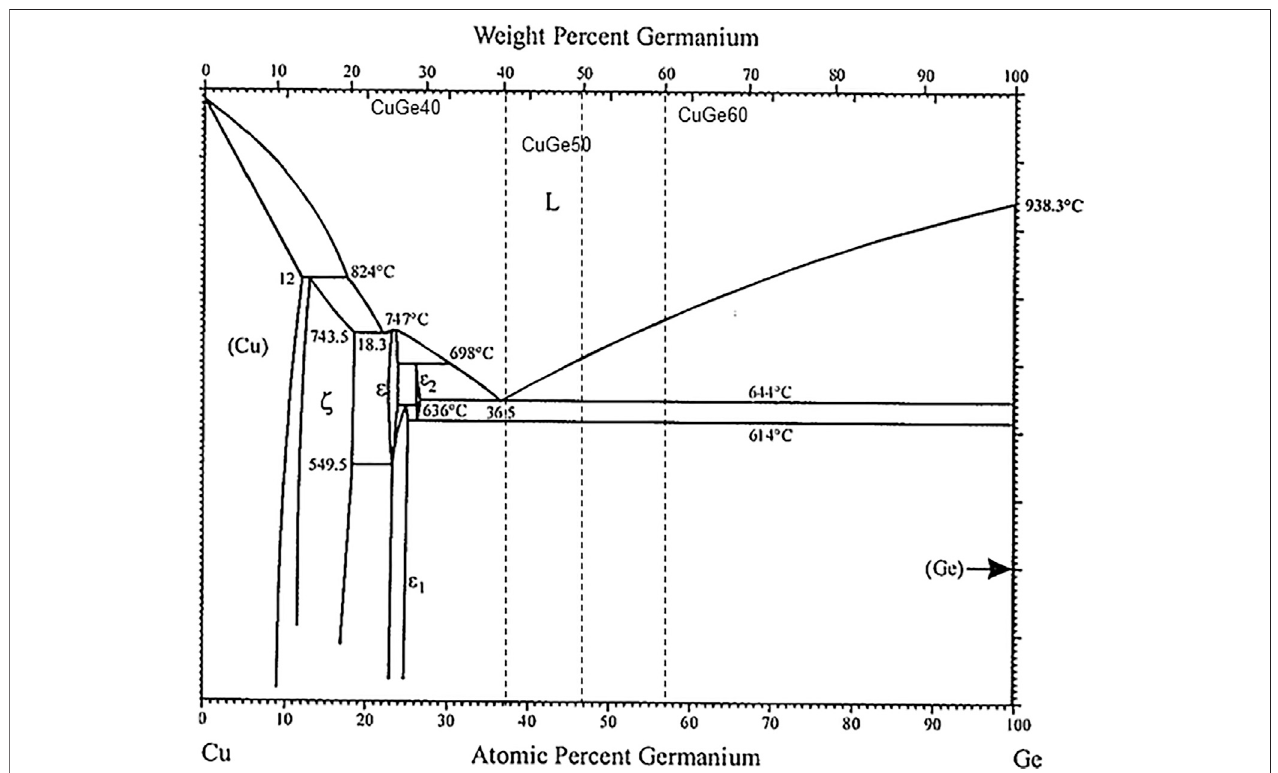
FIGURE 1 | Binary phase diagram of Copper and Germanium (Okamoto,